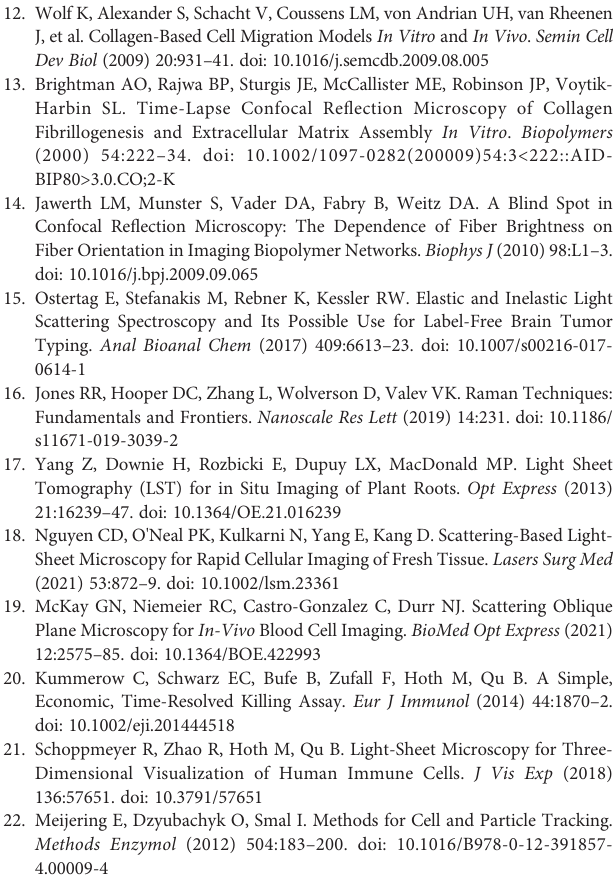
Figure 1 “ LSSM for long-term ECM-cell interaction_Fig.1 ” , Mendeley Data, V1, doi: 10.17632/v5259wncpw.1. Figure 2 “ LSSM for long-term ECM-cell interaction_Fig.2 ” , Mendeley Data, V1, doi: 10.17632/6vphrtcvpz.1. Figure 3 and Figure 4 “ LSSM for long-term ECM-cell interaction_Fig.3+Fig. 4 ” , Mendeley Data, V1, doi: